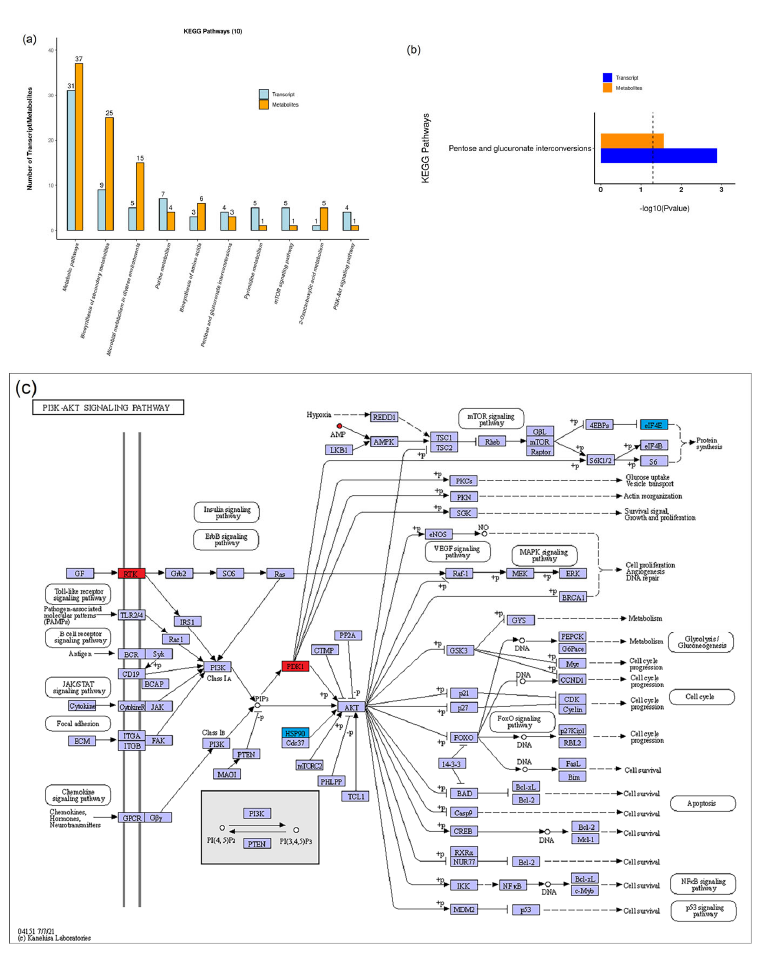
Figure 9. Comparative analysis of transcript and metabolite KEGG pathway annotation. ( a ) The 10 pathways with the largest number of DEGs and DAMs participating together. Each column represents a KEGG pathway, blue represents the transcriptome and orange represents the metabolome. From left to right, the number of genes or metabolites is arranged from high to low. ( b ) Enrichment of DEGs and DAMs in pentose and glucuronate interconversions pathway. ( c ) Map of gene expression and metabolite abundance differences in the PI3K-Akt signaling pathway in gregarious armyworms compared with solitary armyworms. DEGs and DAMs are marked in red and blue. Red indicates upregulation and blue